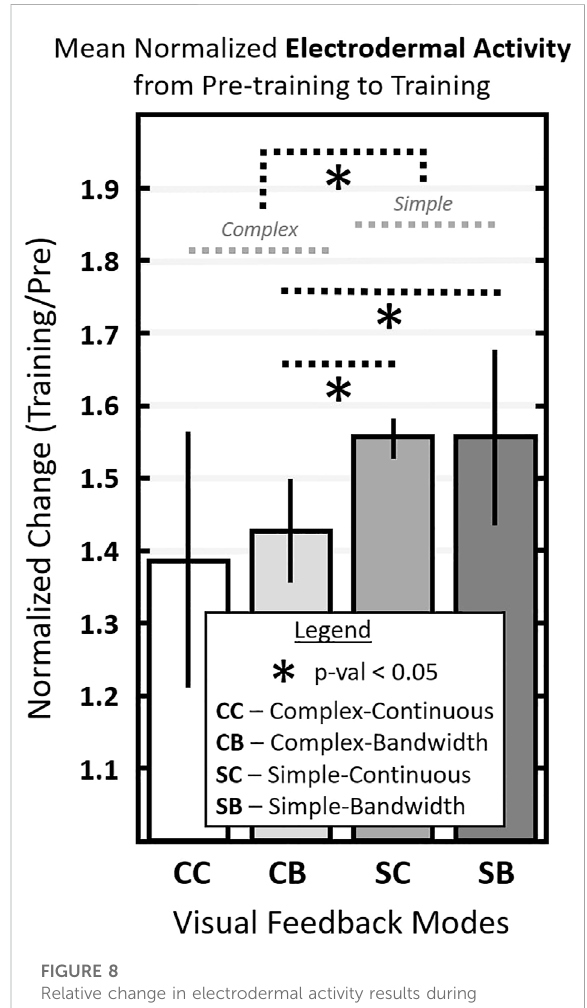
FIGURE 8 Relative change in electrodermal activity results during training compared to pre-training with each feedback